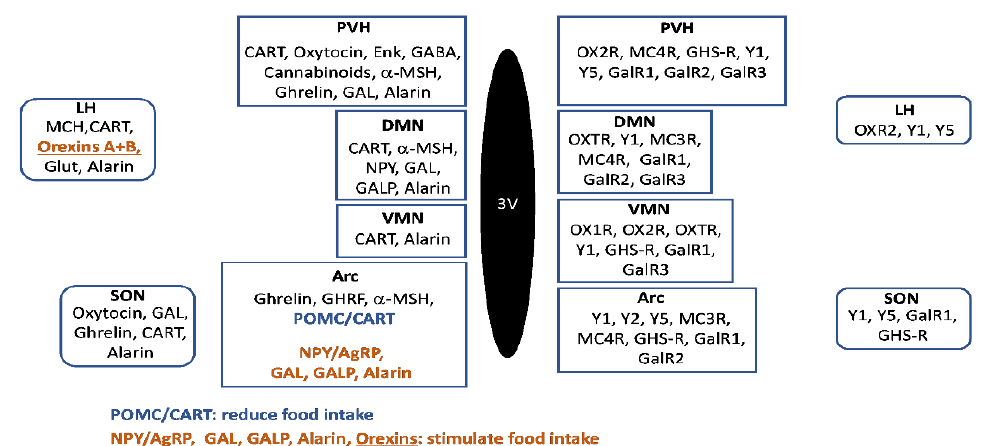
Figure 1. Schematic representation of the main hypothalamic regions implicated in the control of food intake. Neuroactive substances involved in feeding regulation are represented at the right side of the image, and receptors are represented at the left part of the schema. Abbreviations: 3V—third ventricle; AgRP—agouti-related peptide; Arc—arcuate hypothalamic nucleus; α -MSH—alpha-melanocyte stimulating hormone; CART—cocaine and amphetamine regulated transcript; DMN—dorsomedial